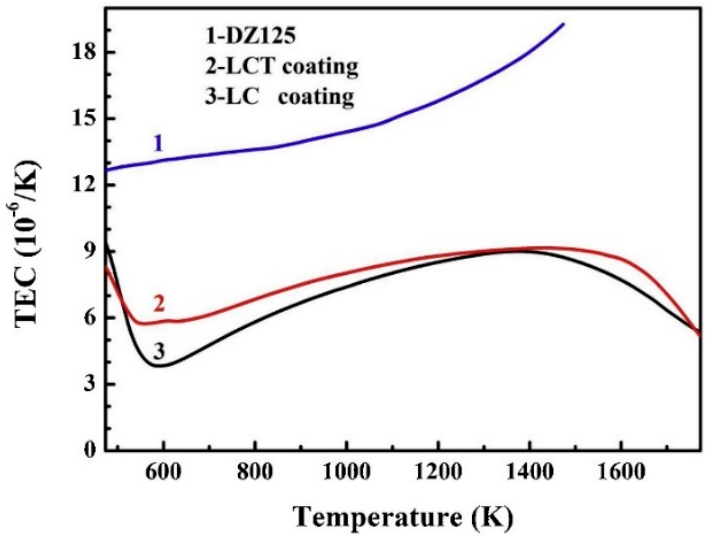
Figure 7. Thermal expansion coefficient trend chart of La 2 Ce 2 O 7 (LC) coatings, Ta 2 O 5 doped La 2 Ce 2 O 7 (LCT) coatings and DZ125 substrate [96].